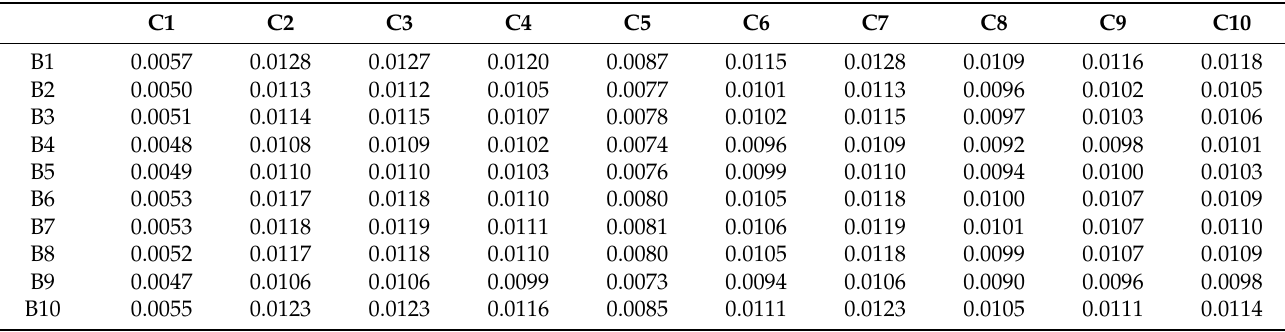
Table 16. The standardised initial matrix